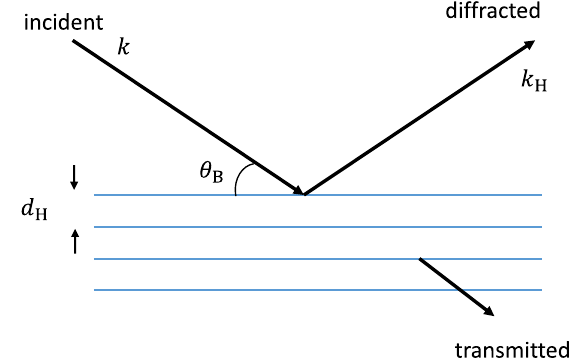
FIG. 1. A symmetric x-ray diffraction. The blue lines are the virtual atomic planes. k is the wave number of incident x-ray, and k is reflected one. θ is the Bragg H B